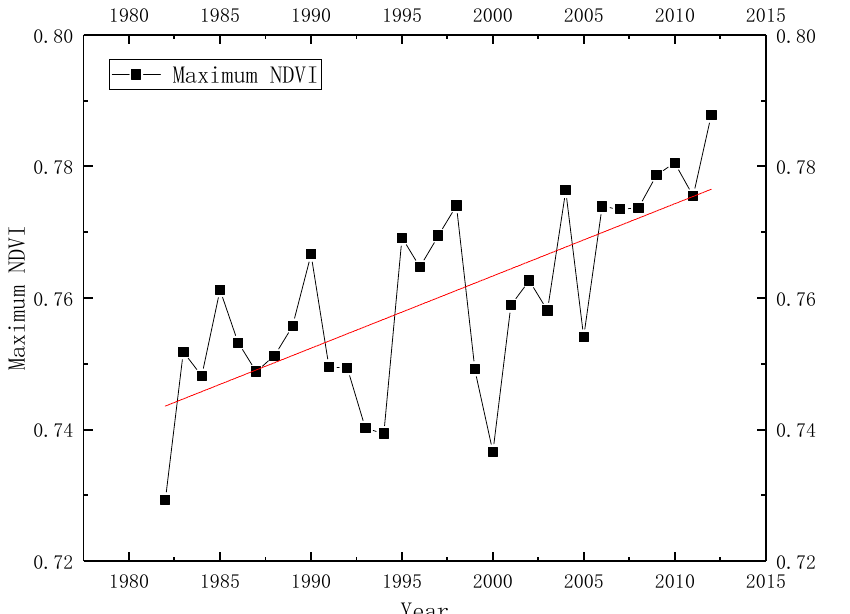
Figure 2. Temporal variations of maximum normalized difference vegetation index (NDVI) in the MLR-YR from 1982 to 2012.